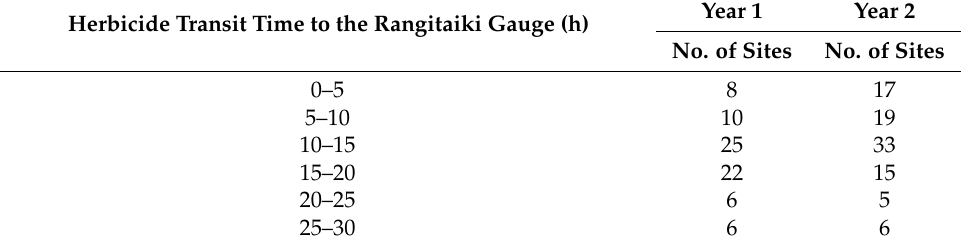
Table 3. Estimated herbicide residue transit times from the sites to the Rangitaiki flow gauge. Herbicide Transit Time to the Rangitaiki Gauge